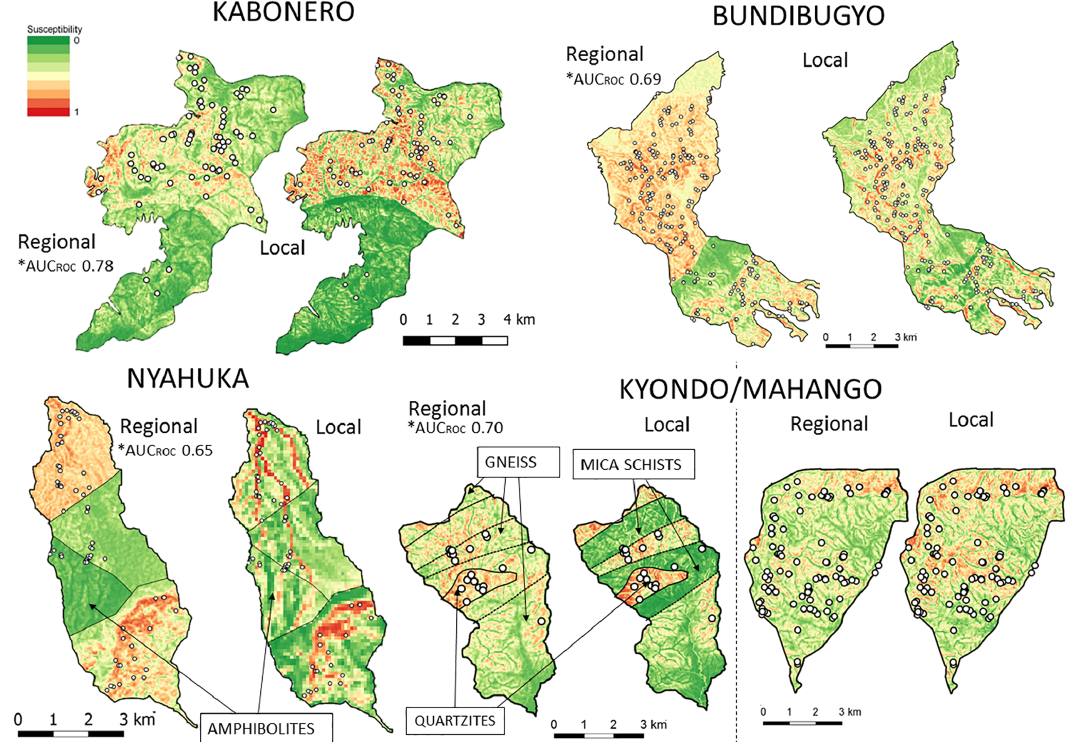
Figure 4. Pairwise comparison of the regional susceptibility model (left) and the local model (right) applied to the five case study areas. Dots represent landslide locations. Each of the models are achieved by averaging results of the 20 model runs for the selected variant. ∗ Indicates the average performance in AUC ROC for the regional model as applied to the local study area.